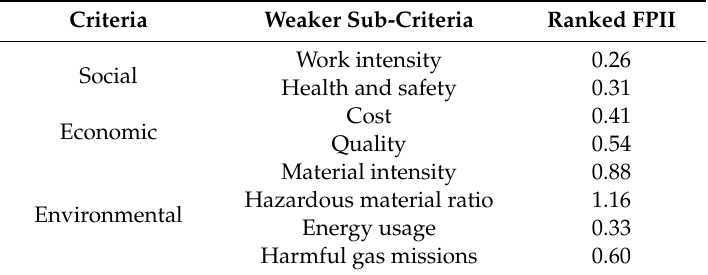
Table 12. The weak points and corresponding criteria.